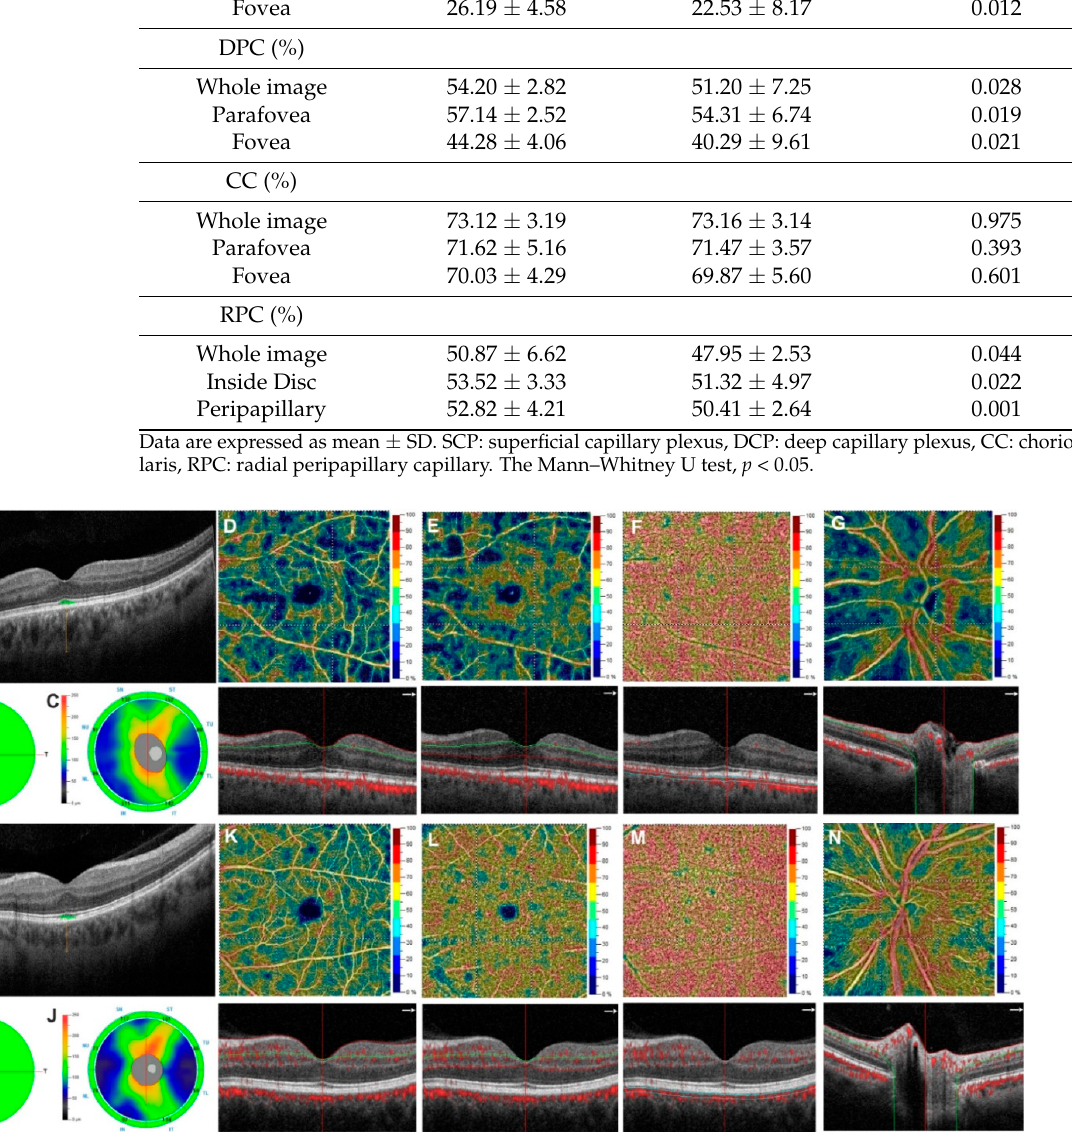
Table 3. Differences in OCT angiography vessel density between controls and patients.